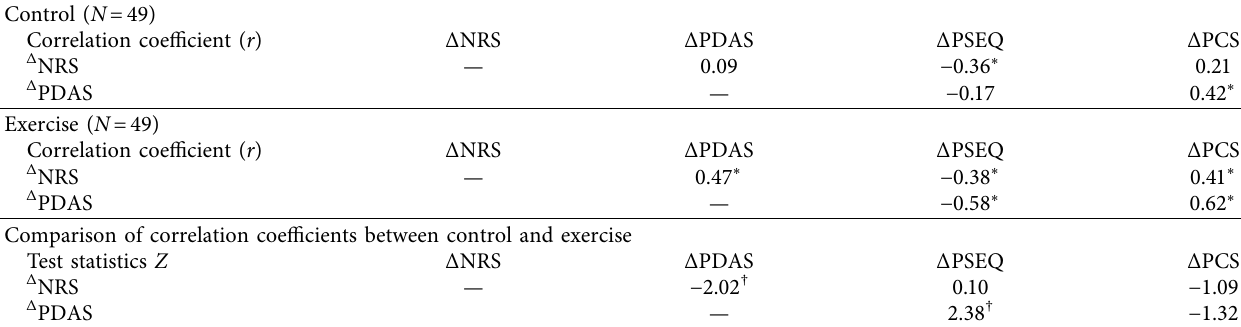
Table 4: Correlation analyses between changes in pain and disability and psychological status during the follow-up and comparison of the correlations between control vs. exercise.